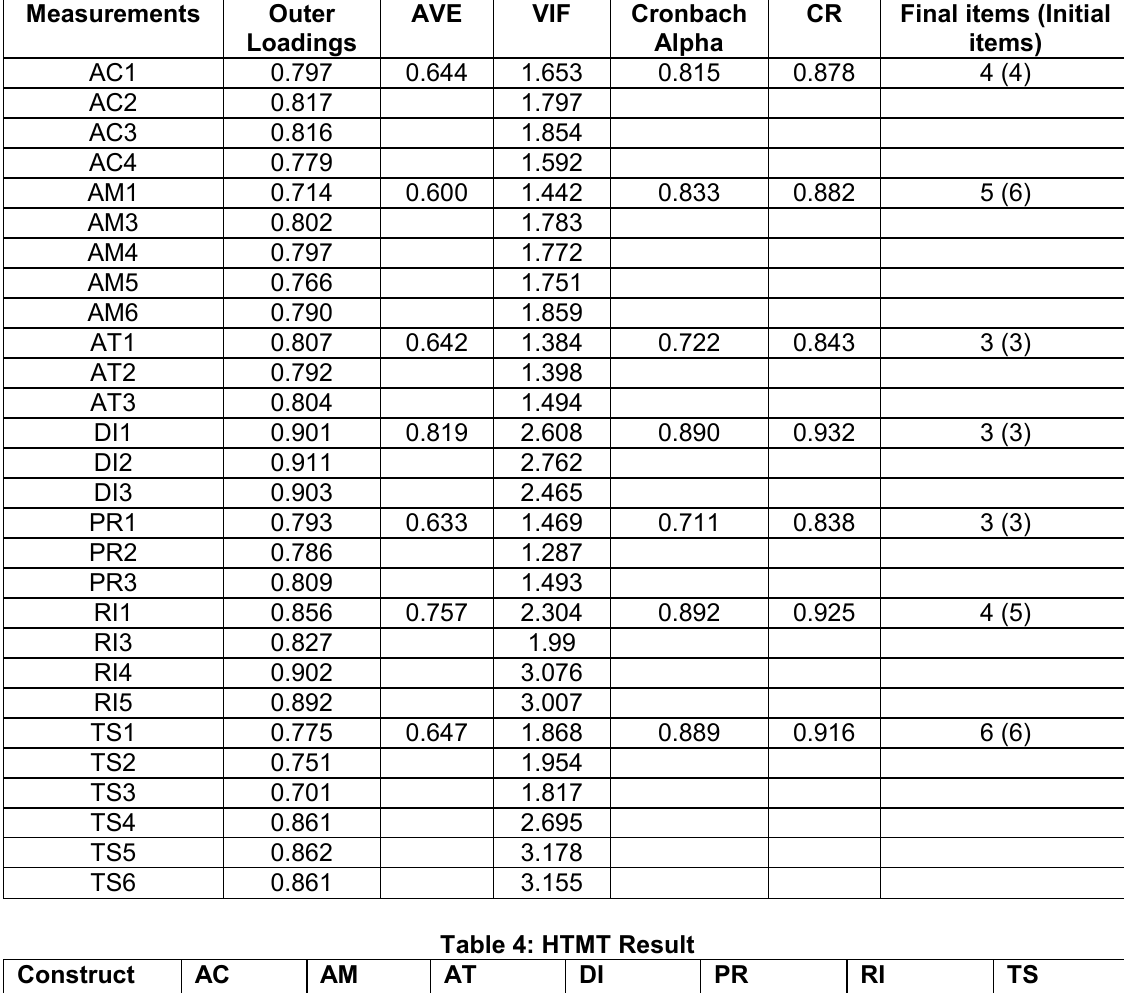
Table 3: Validity and Reliability Result